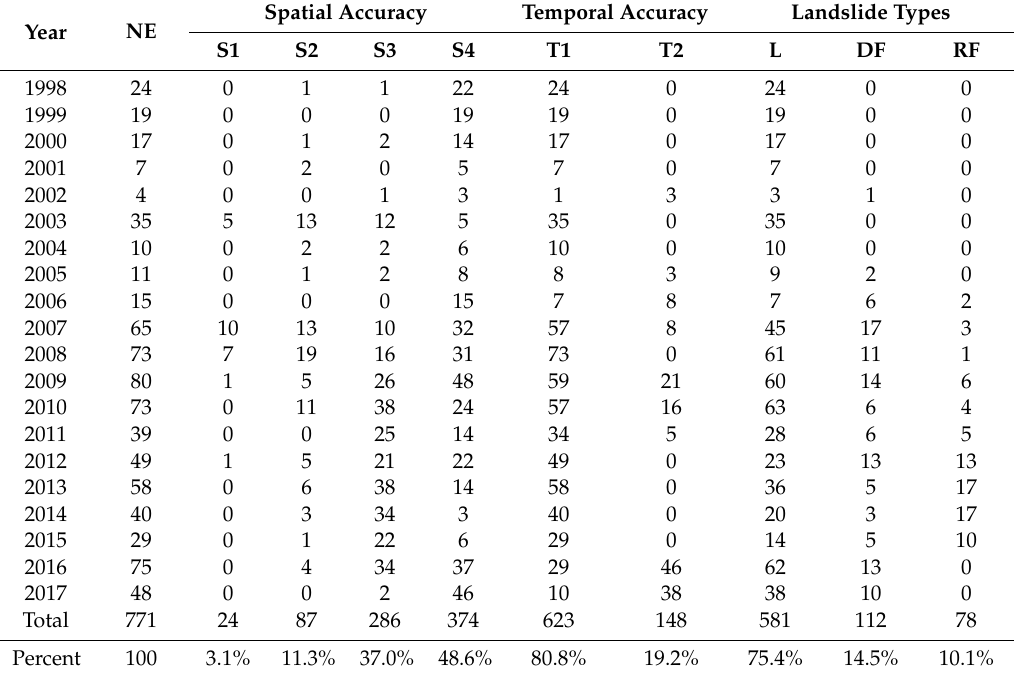
Table 1. Information of landslide inventory in China during 1998–2017. NE: number of